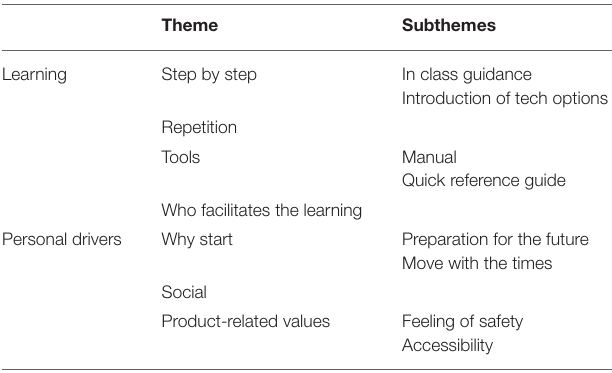
TABLE 2 | Our thematic analysis with the two overarching themes “learning” and “personal drivers” including their themes and subthemes.